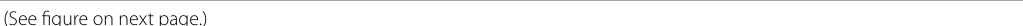
artery(See figure on next Fig. 1 a – e View onto the renal capsule (C light blue/zigzag) and the external part of the nephrogenic zone (NZ) in the a fetal human kidney during advanced pregnancy and b – e the neonatal rabbit kidney. a By the optical microscope, one can recognize in the external capsula fibrosa (CF) arterial, venous, and lymphatic vessels between the bundles of collagen. In the subjacent tunica muscularis (TM), smooth muscle cells are seen. Between the inner side of the renal capsule and the tip of a CD ampulla (A dark blue/vertical double arrow), a transverse outer layer of interstitial/stromal (SP) and 2 to 3 inner layers of nephrogenic (NP) progenitor cells are present. The innermost layer is separated by a clear interface (black asterisks) from the subjacent tip of a collecting duct (CD) ampulla (A). b Immunohistochemical label for collagen type 3 depicts that the tip of a CD ampulla is linked via microfibers (arrow head) with the inner side of the renal capsule. c Contrasting by tannic acid for transmission electron microscopy illustrates a pronounced label at the interface, which surrounds the tip of a CD ampulla. Higher magnification of d tannic acid or e cupromeronic blue contrasted specimens indicates that textured extracellular matrix is contained at the lamina rara (Lr), densa (Ld), and fibroreticularis (Lf) of the here occurring basal lamina. PTA, pretubular aggregate (black arrow, PRA), perforating radiate